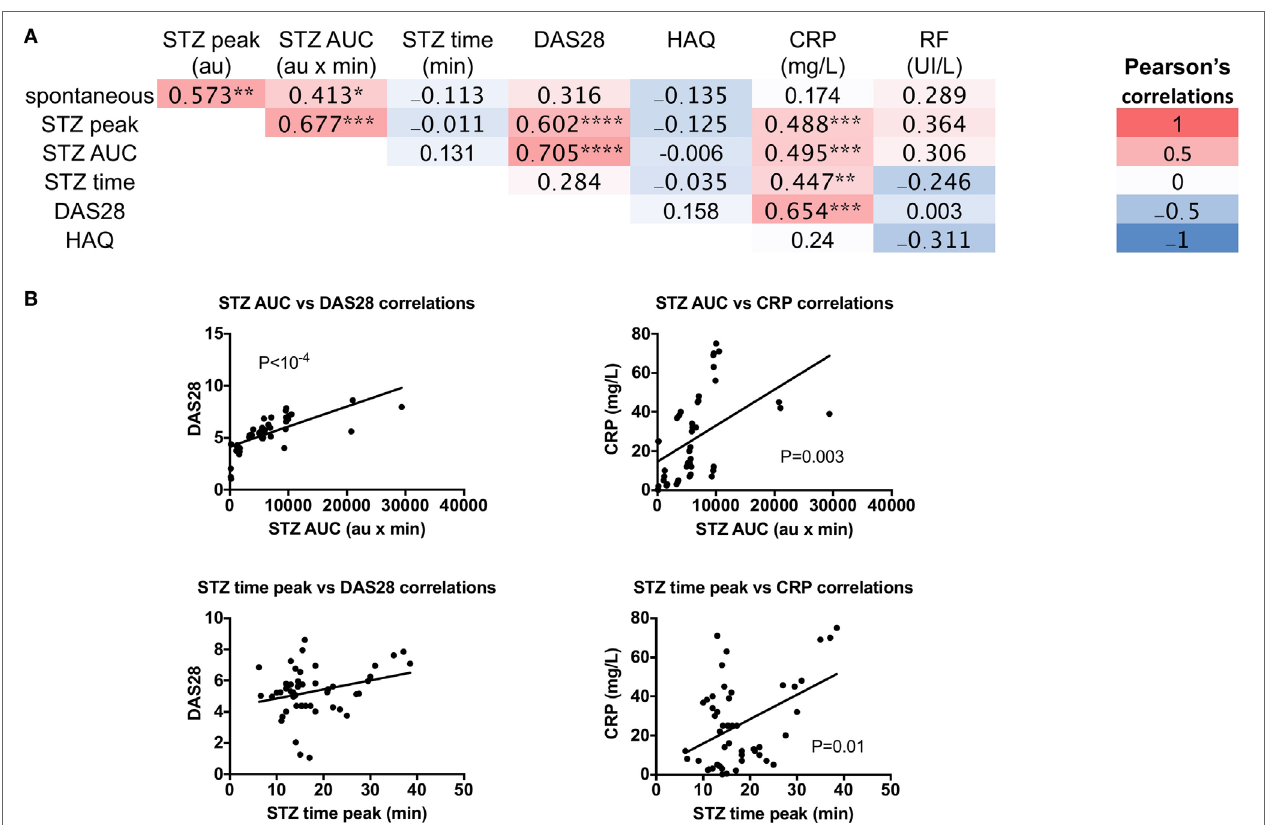
FigUre 3 | Correlations between granulocyte reactive oxygen species (ROS) production serum-treated zymozan (STZ) stimulation at peak, area under the curve (AUC), time to reach peak ROS production, and rheumatoid arthritis (RA) parameters: erythrocyte sedimentation rate-based 28 joints disease activity score (DAS28), the Health Assessment Questionnaire (HAQ), C-reactive protein (CRP), and rheumatoid factor (RF) levels in RA patients. (a) Correlation table of RA parameters. Colors represent the correlation coefficients (red being the highest and blue the lowest), whereas statistical significances (*) denotes the calculated P values * P ≤ 0.05, ** P ≤ 0.01, *** P ≤ 0.001, and **** P ≤ 10 − 4 . (b) Significance of correlations between ROS and RA parameters, the Spearman’s P -value is indicated for each